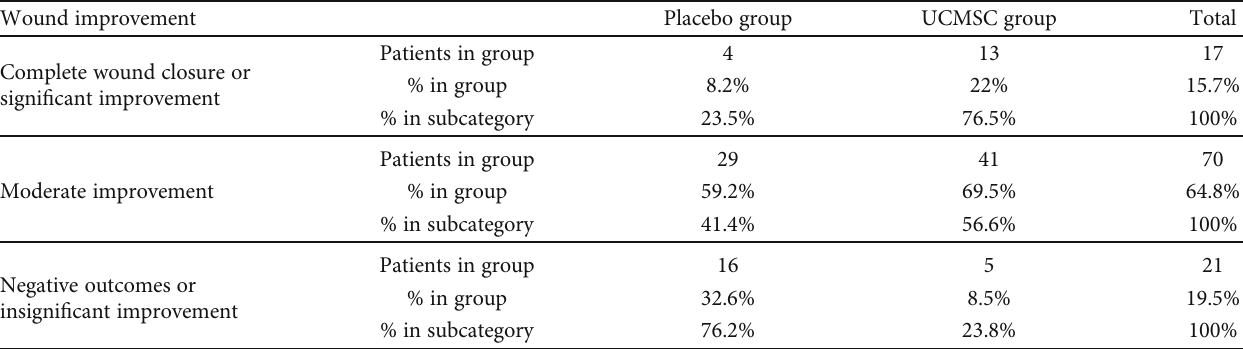
Table 3: Cases of wound improvement and closure among the patients 4 weeks after the treatment ( χ 2 test, p < 0 : 05 ). Wound